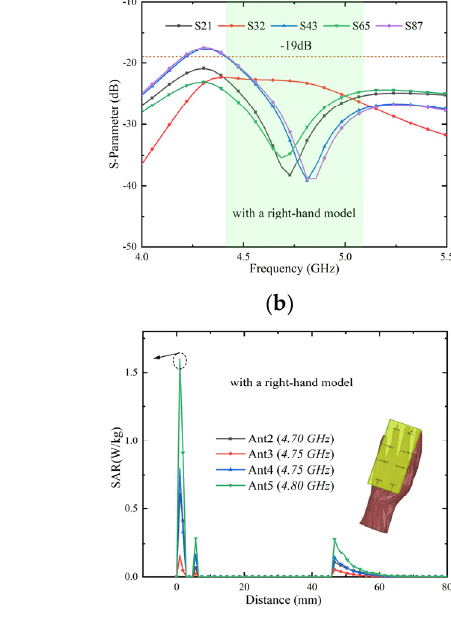
( b ) Figure 18. Simulated 3-D radiation patterns of Ant 1 of the proposed MIMO antenna system at 4.75 GHz. ( a ): Radiation pattern with a right-hand model and ( b ): radiation pattern without a right-hand model. First, the designed antenna grabbed by a right hand is set up and simulated. Due to the direct contact of the fingers with the antenna, inevitable shocks may be caused to the antenna elements, resulting in some performance degradation. In Figure 19a, the imped-